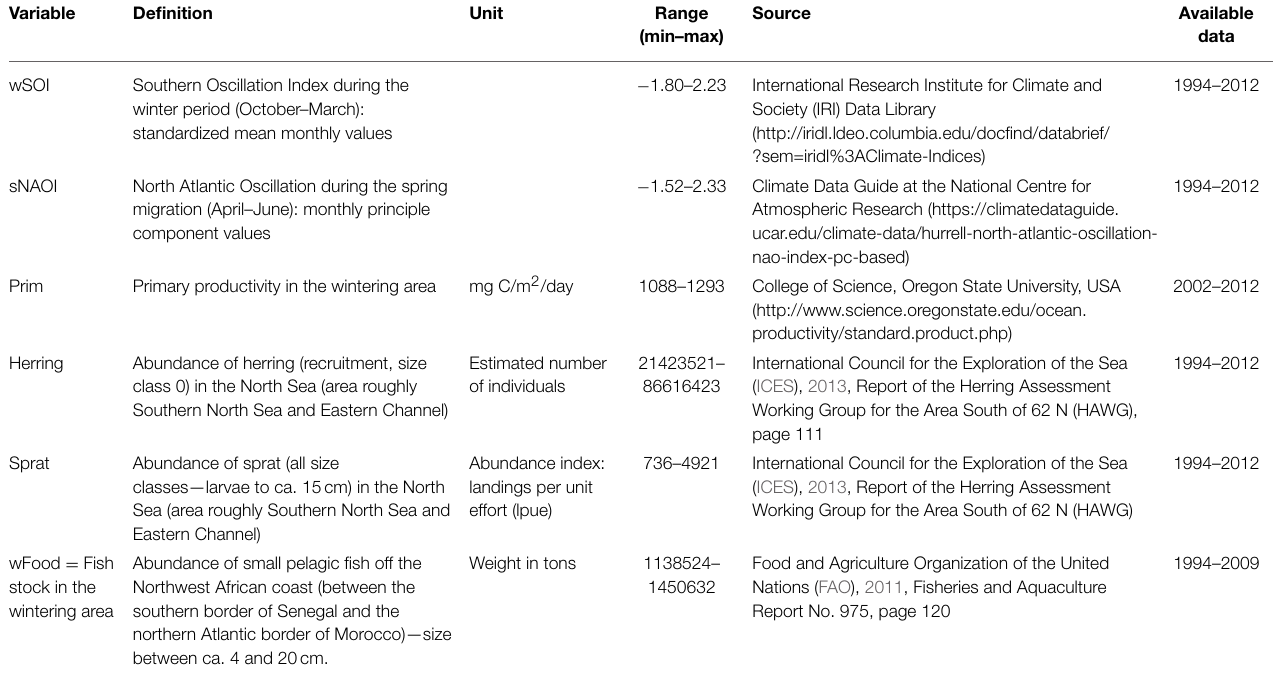
TABLE 1 | Covariates used in statistical analyses: abbreviation, definition, source and available timeframe.